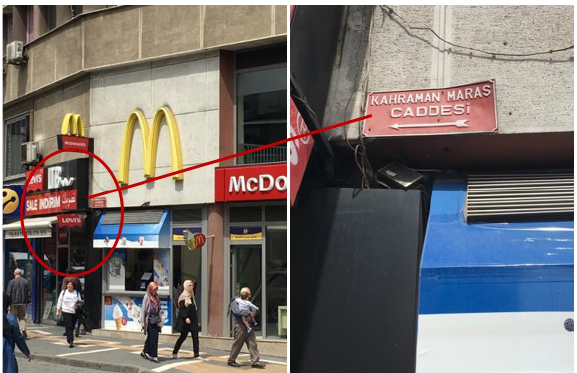
Figure 5. Directional signs of study field, Trabzon city ( Ataoğlu,